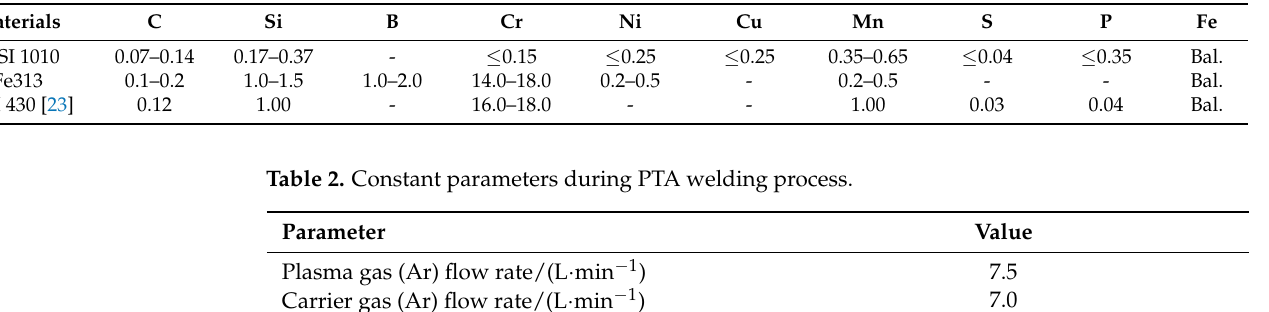
Figure 1. ( a ) XRD pattern. Inset: EDX spectrum showing peaks of each element. ( b – d ) SEM images for Fe313 feedstock powders presenting their overview and representative morphology. Table 1. Chemical composition (wt.%) of substrate, Fe313 self-fluxing powders and AISI 430 FSS.